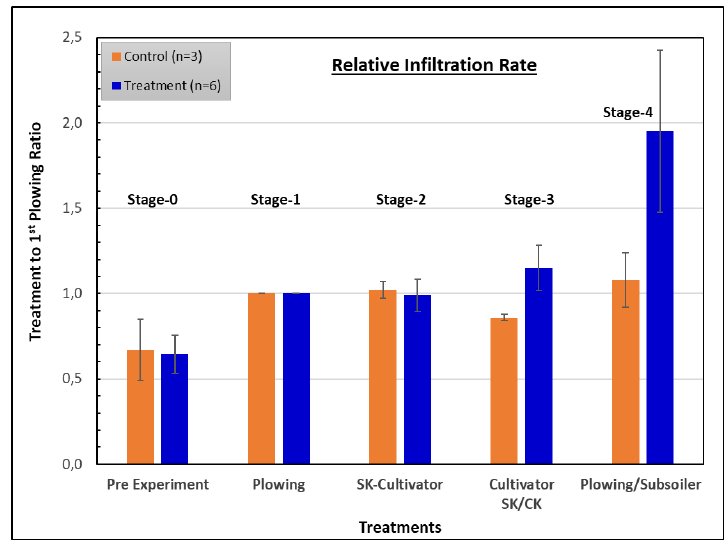
Figure 4. Relative infiltration rates (average ± standard deviation) calculated for each stage and treatment, relative to the average IR measured during Stage 1 (first plowing).